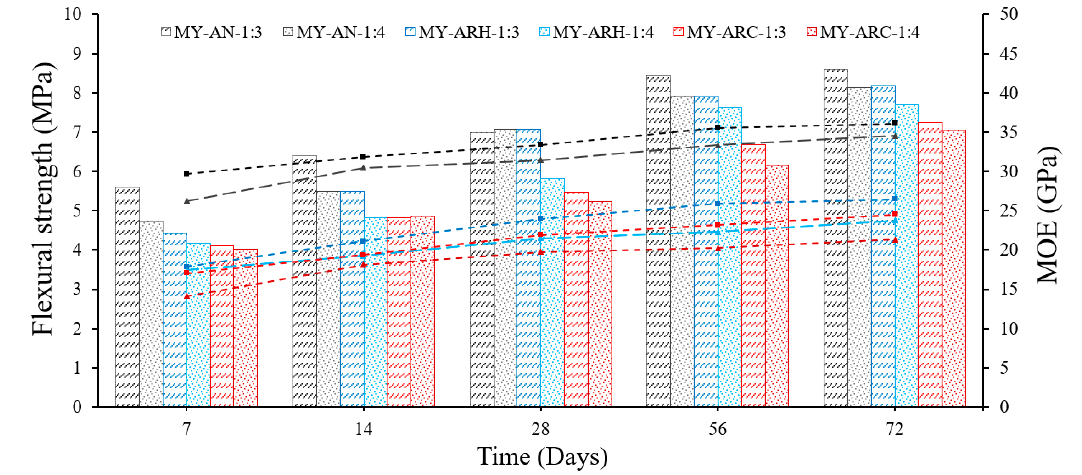
Figure 9. The evolution of the flexural strength (bars) and dynamic Young’s Modulus (dotted lines) measured over time for the different dosages used.